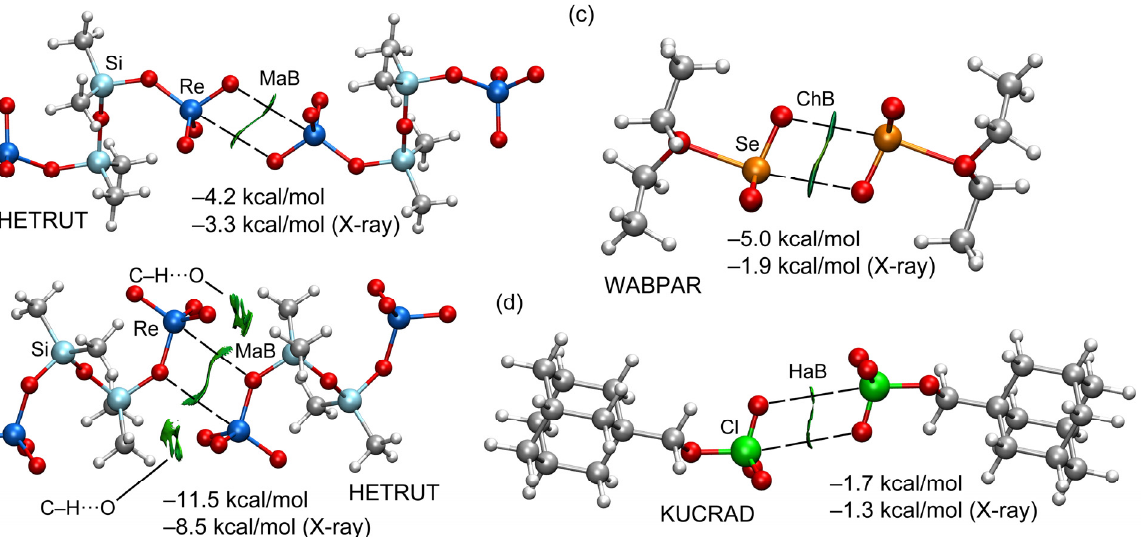
Figure 5. NCIPlot analyses of the dimers of HETRUT ( a , b ), WABPAR ( c ) and KUCRAD ( d ). The dimerization energies using both the optimized and X-ray geometries are indicated at the PBE0- D3/def2-TZVP level of theory. Isovalue for the RDG isosurface 0.45.